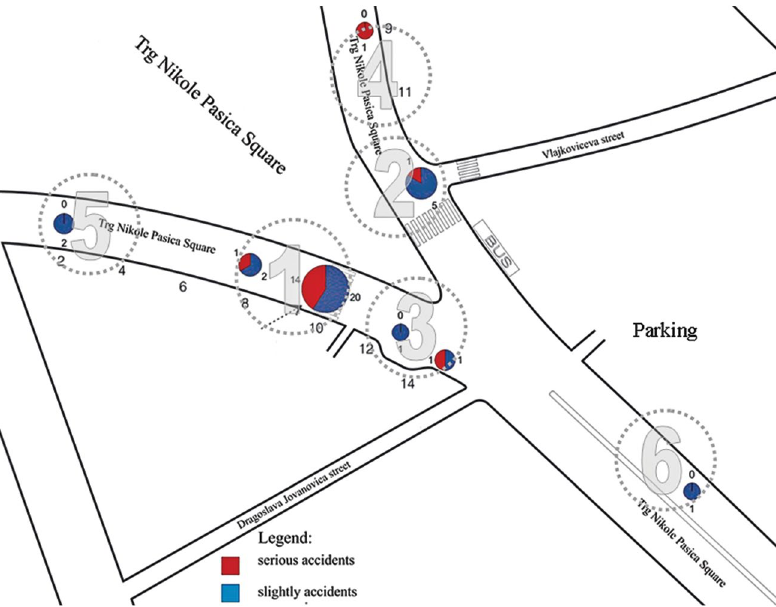
Fig. 4. The spatial distribution of traffic accidents (Vujanić et al. 2009b)